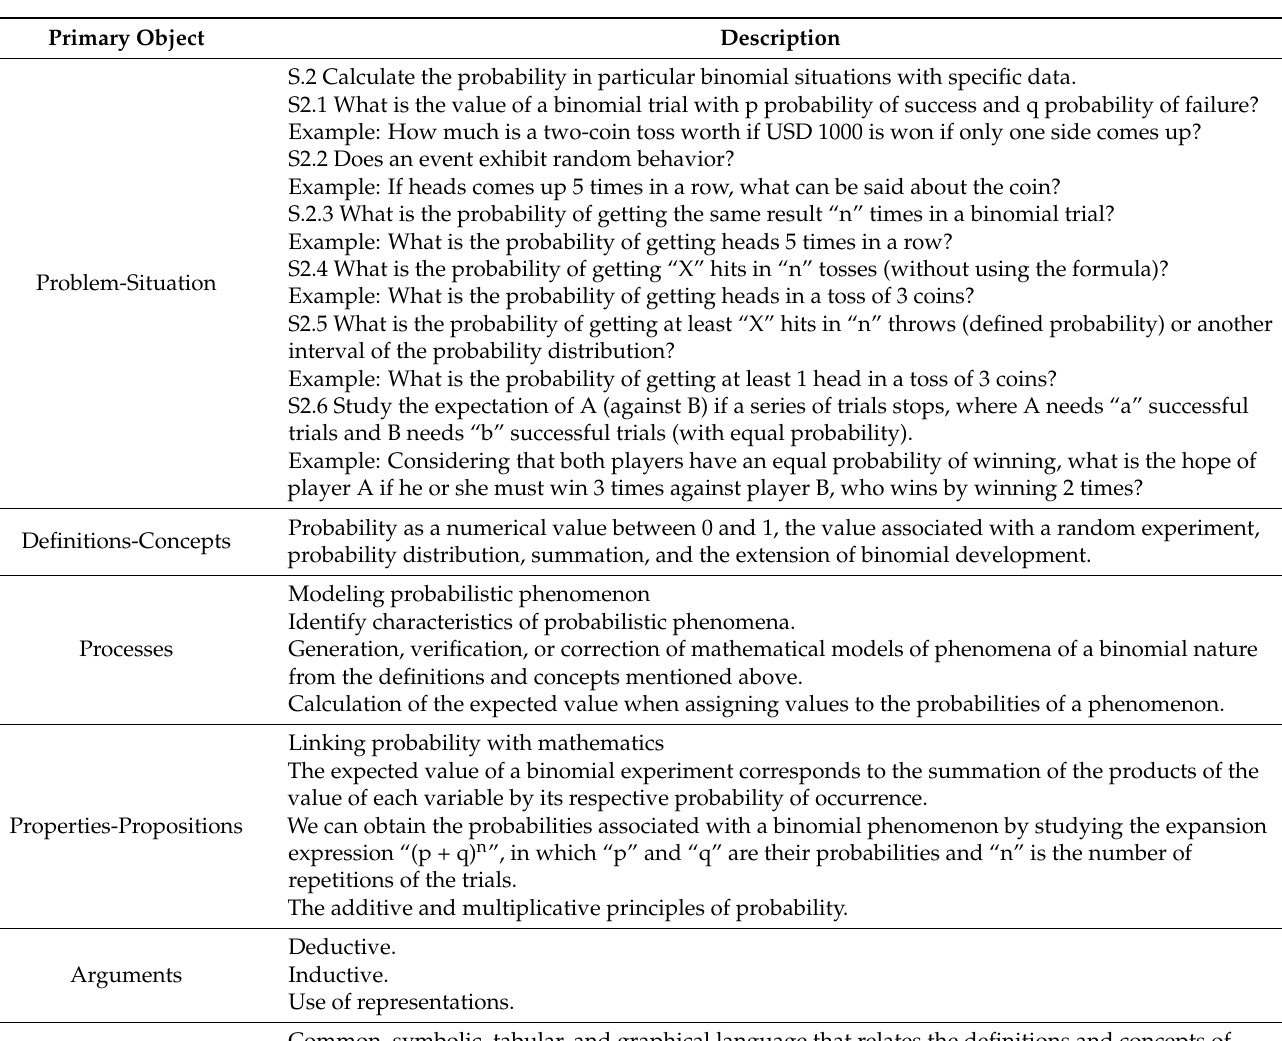
Table 13. Primary objects of the second meaning of the binomial distribution.